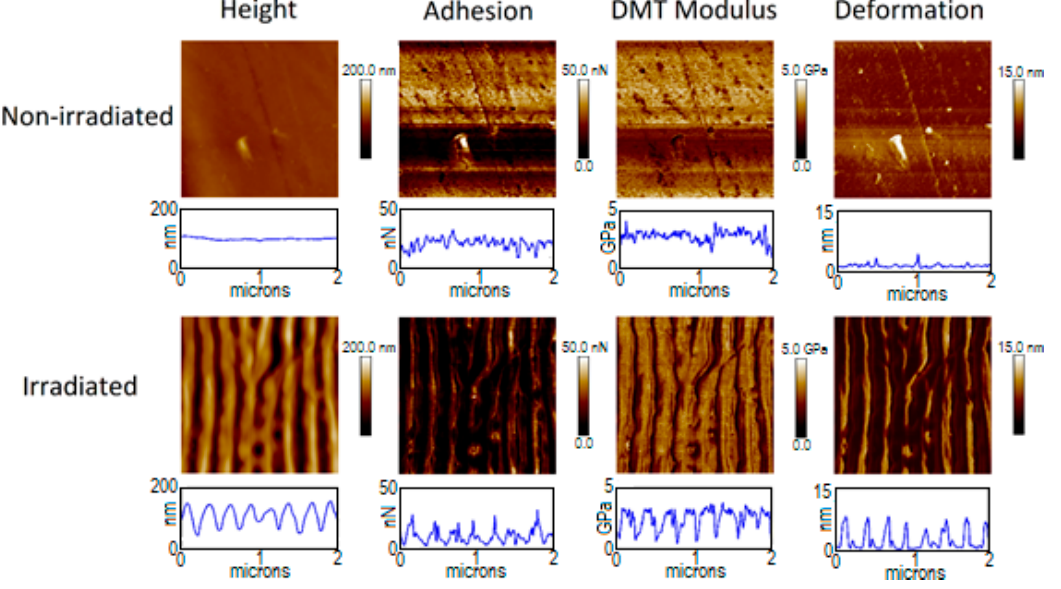
Figure 3. PF-QNM measurements of PTT surfaces before and after irradiation with 5000 pulses at 20.3 mJ/cm 2 . (2 × 2 μ m 2 images and property profiles over a 2 μ m horizontal line).